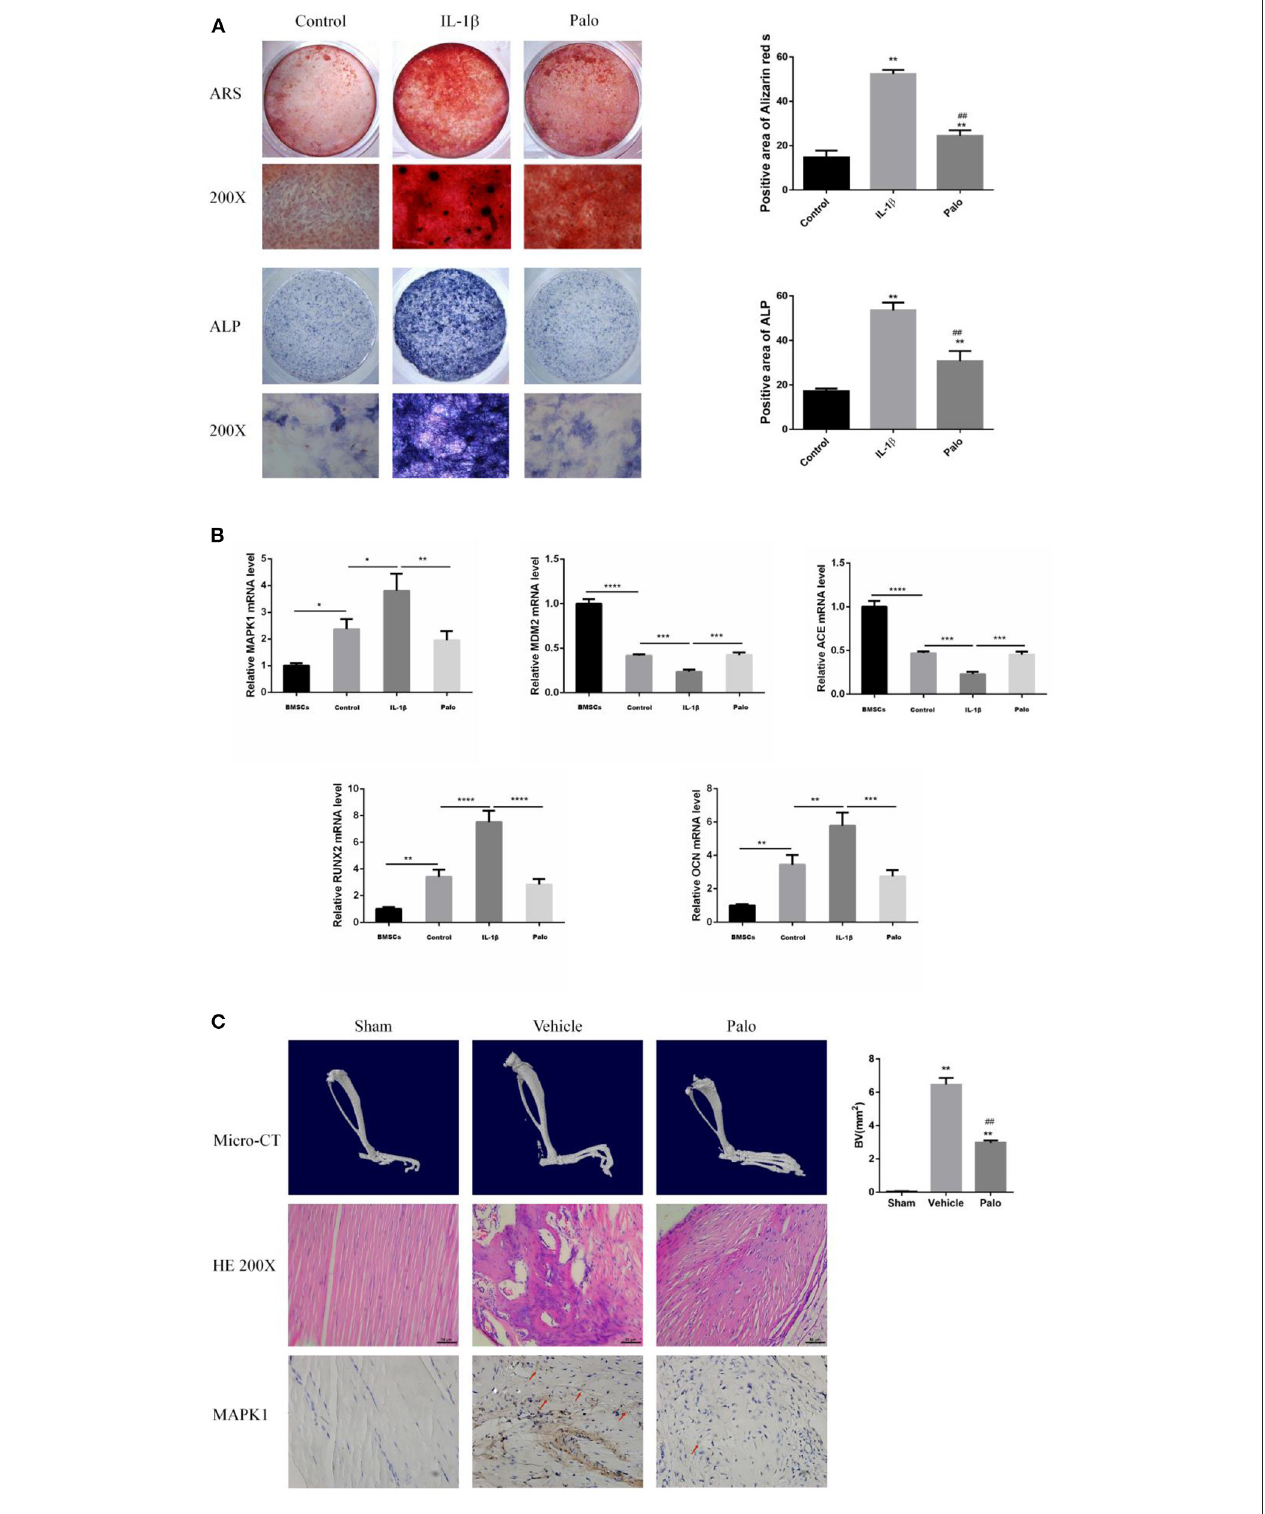
FIGURE 7 | Screening target validation and Palovarotene against HO validation experiments. (A) ALP and ARS staining in BMSCs after culture with osteogenesis induction. Data are means ± SD ( n = 3) * P < 0.05, ** P < 0.01, * compared with the Control group. # P < 0.05, ## P < 0.01, and # compared with the IL-1 β group. Scale bar: 100 µ m; (B) The mRNA expression and relevant quantitative analysis of MAPK1, MDM2, ACE, Runx2, and OCN. Data are means ± SD ( n = 3) * P < 0.05, ** p < 0.01, *** P < 0.001, and **** P < 0.0001; (C) images of Micro-CT, HE staining and IHC. Data are means ± SD ( n = 8) * P < 0.05, ** p < 0.01, and * compared with the Sham group. # P < 0.05, ## P < 0.01, and # compared with the Vehicle group. Scale bar = 50 µ m.